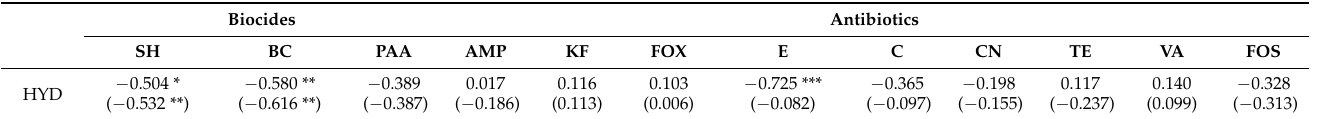
Table 7. Coefficients of correlation between hydrophobicity and MIC or MBC values of twelve biocides and antibiotics in eight strains of Listeria monocytogenes